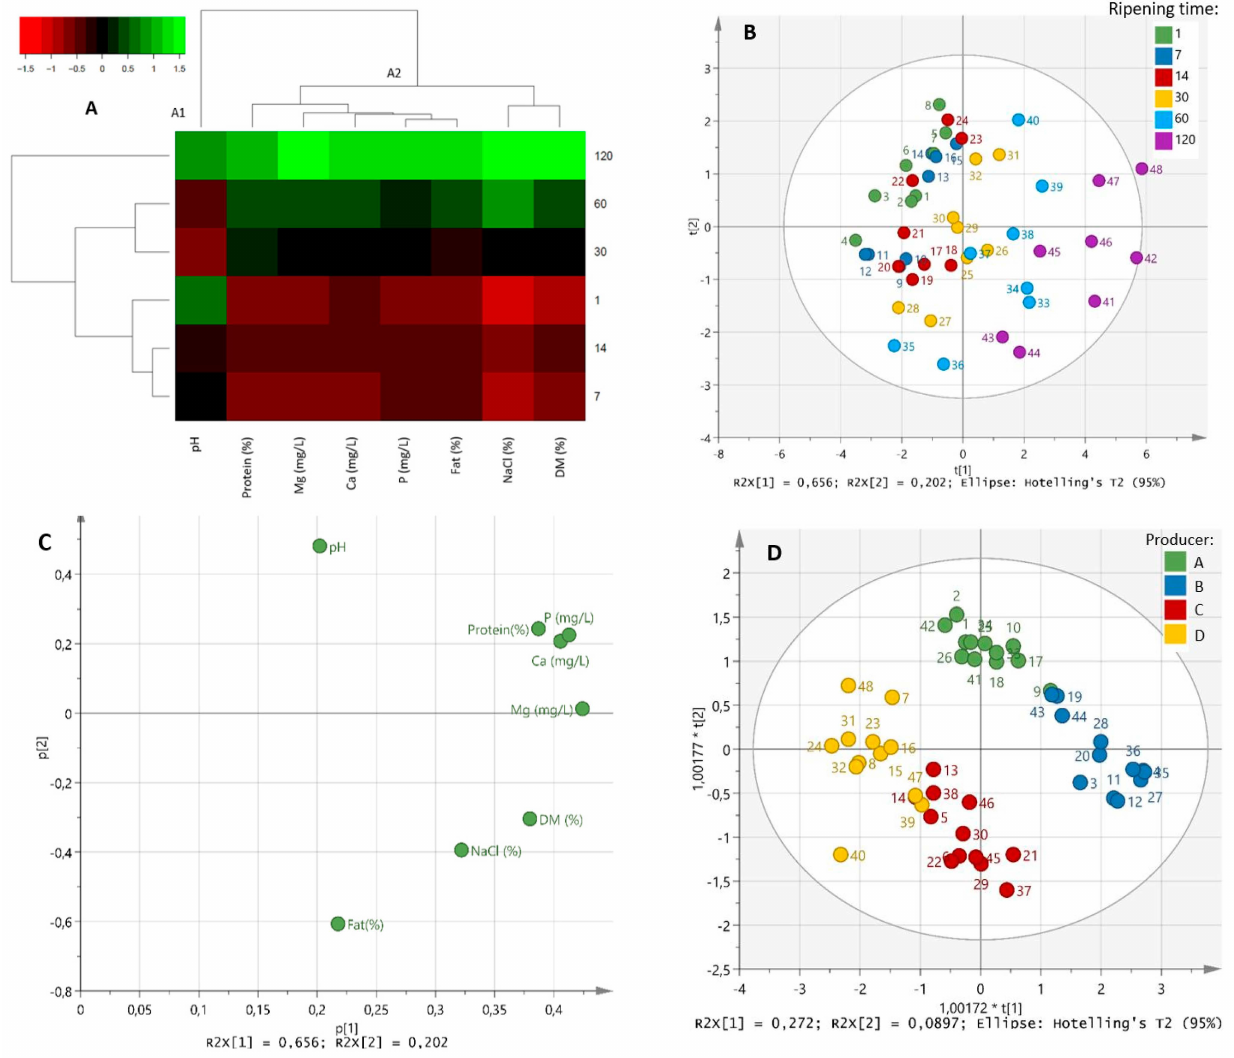
Figure 1. HCA heat map ( A ), scores and loadings plots of PCA ( B and C , respectively) and scores plot of the OPLS-DA based on the producer of the analysed gross composition parameters during ripening (1, 7, 14, 30, 60 and 120 days) ( D ). The scale values of the HCA correspond to log-transformed and UV scaled